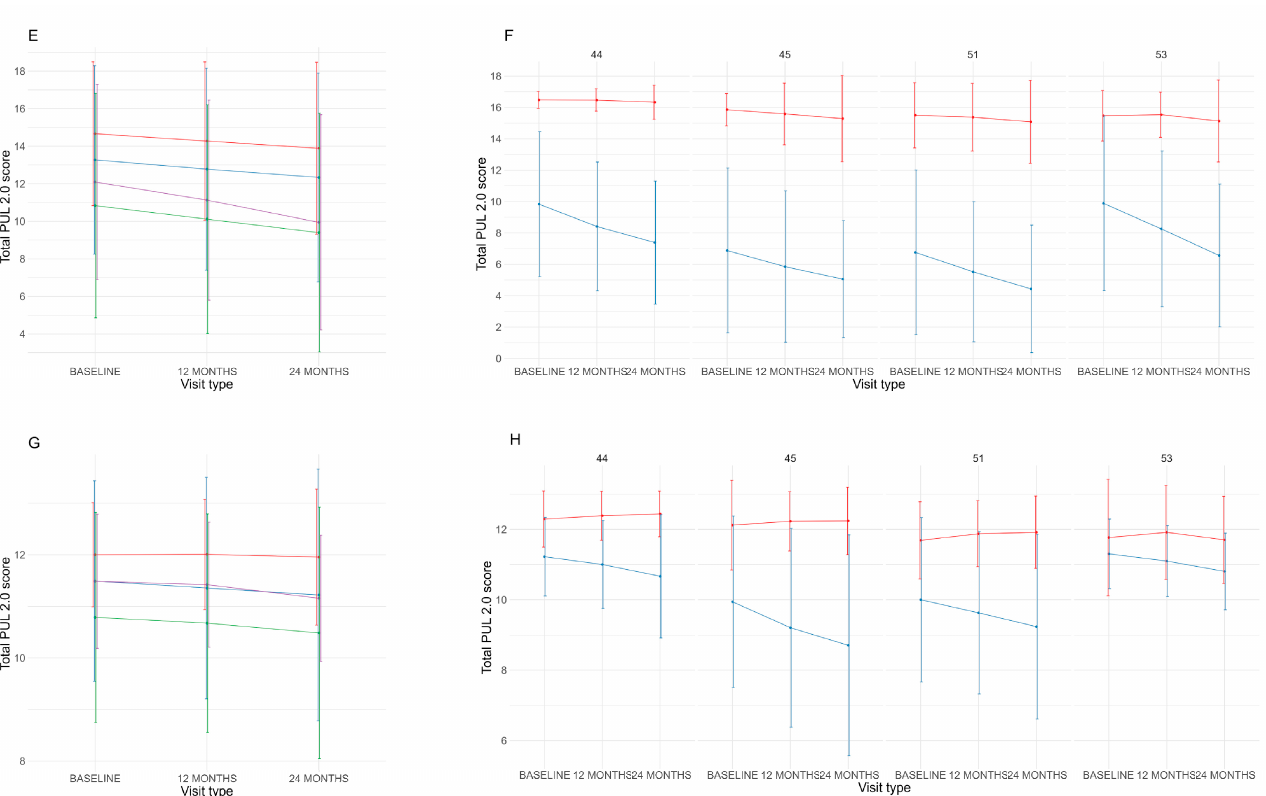
Figure 2. Baseline, 12- and 24-month PUL scores (mean and SD) subdivided in exon-skipping classes (red: amenable to skip 44, blue: amenable to skip 45, green: amenable to skip 51, purple: amenable to skip 53). and to ambulatory status (red: ambulant, blue: non-ambulant). Key to figure: Total score ( A , B ), shoulder domain ( C , D ), elbow domain ( E , F ), distal domain ( G , H ).